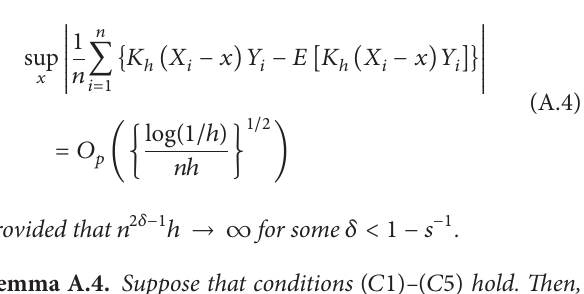
and the dashed curve is the pointwise confidence interval of 𝜃(⋅) . From Table 2, we can see that there is a significant negative correlation relationship between the fat content and the protein and moisture contents. In addition, Figure 3 indicates that the baseline function 𝜃(⋅) really varies over